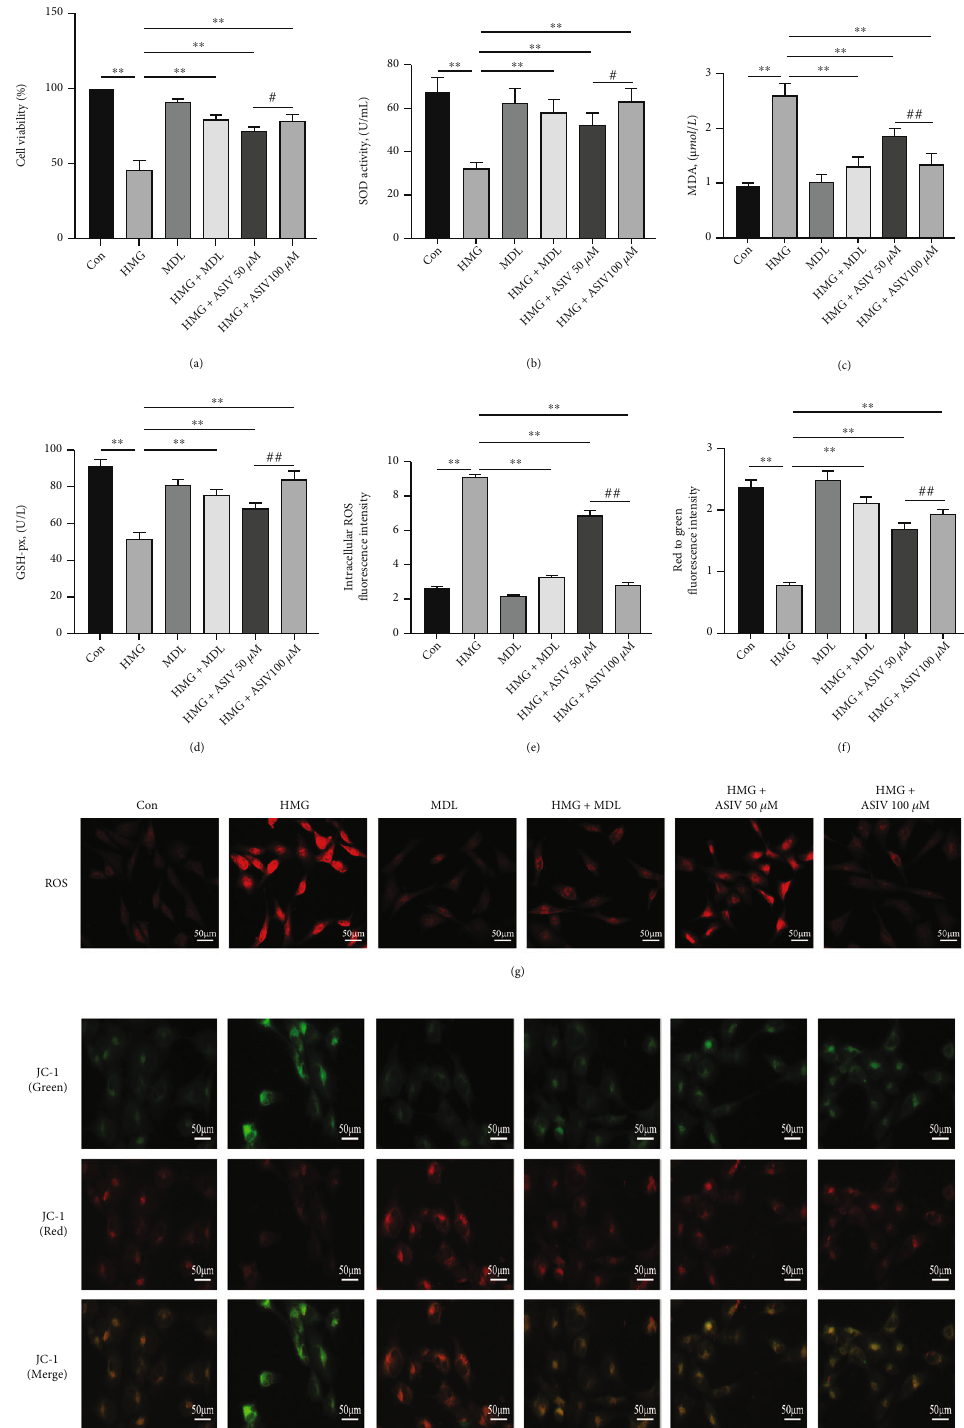
Figure 6: AS-IV improves hypoxia-induced HT22 cell injury and oxidative stress. (a) The cell viability of each group was detected by CCK-8 assay ( n = 4 ; F ð 5,17 Þ = 86 : 359 ). (b – d) Changes in SOD, MDA, and GSH-Px were detected with kits ( n = 4 ; SOD, F ð 5,17 Þ = 15 : 852 ; MDA, F = 36 : 000 ; GSH-Px, F = 56 : 030 ). (e, g) ROS fl uorescence probe was used to observe the expression level of ROS ( n = 3 ; F ð 5,17 Þ ð 5,17 Þ 1162 : 936 ). (f, h) The changes in the mitochondrial membrane potential of HT22 cells were detected by JC-1 ( n = 3 ; F Data are presented as the mean ± SD . ∗∗ P < 0 : 01 compared with the HMG group, # P < 0 : 05 , ## P < 0 : 01 compared with the ASIV 50 μ M